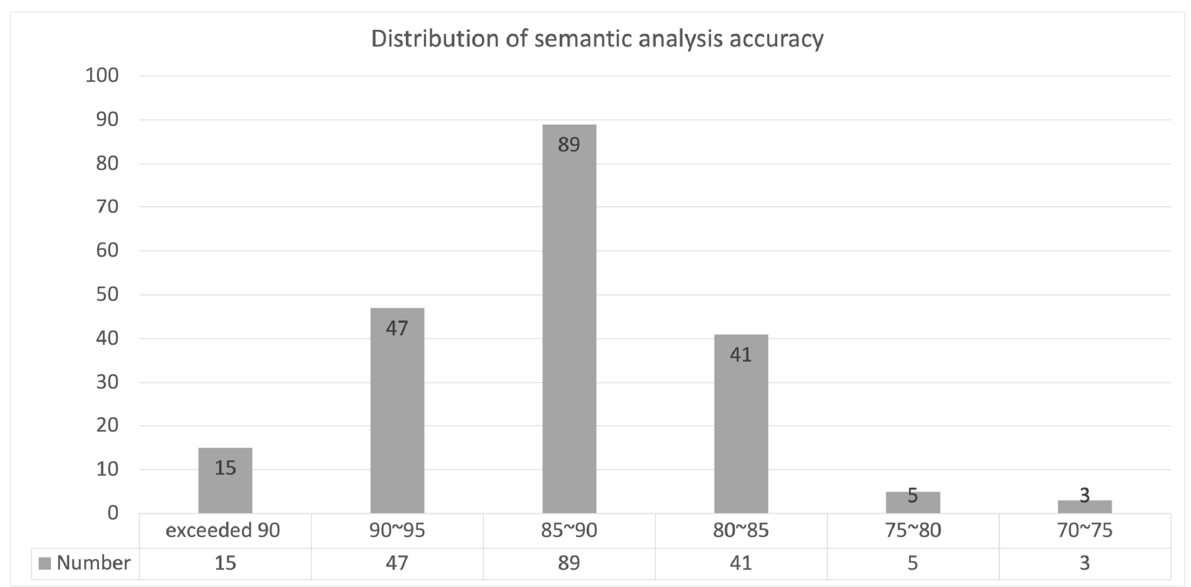
Figure 10. Distribution of semantic analysis accuracy over 200 ambiguous words.